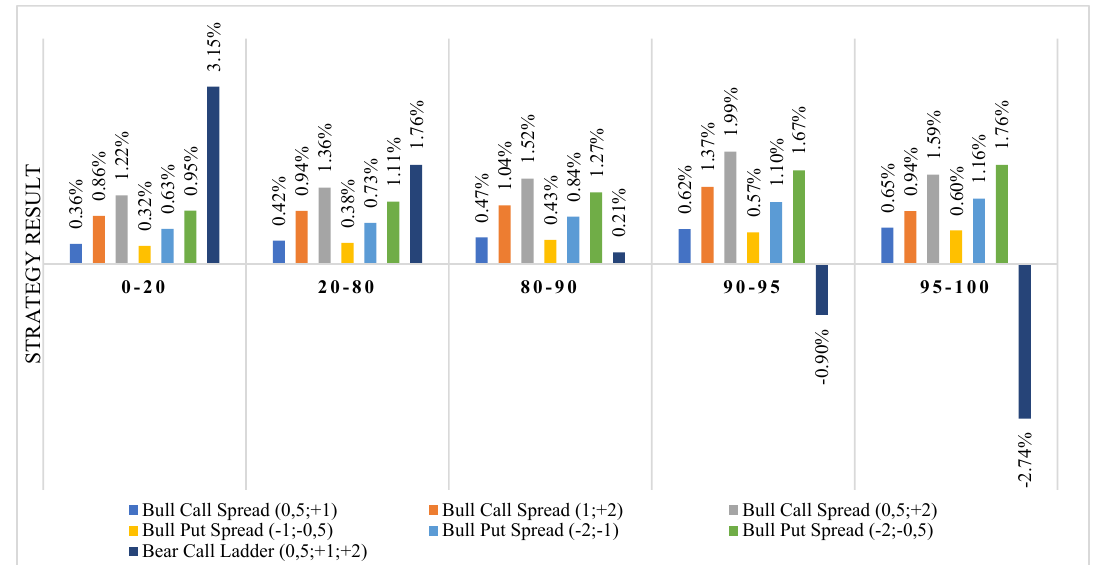
Figure 11. Bull put spread, bull call spread, and bear call ladder results for increases of WTI crude oil prices ranging from 10% to 20%.